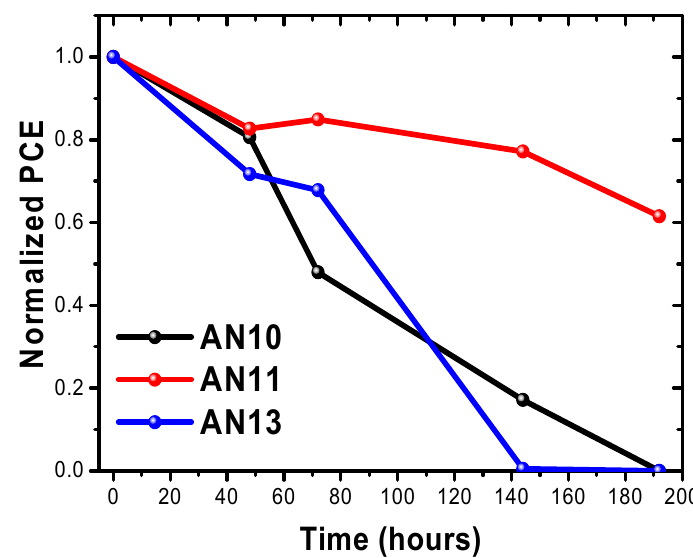
Figure 8. Long-term stability of AN10-, AN11-, and AN13-based PSCs.